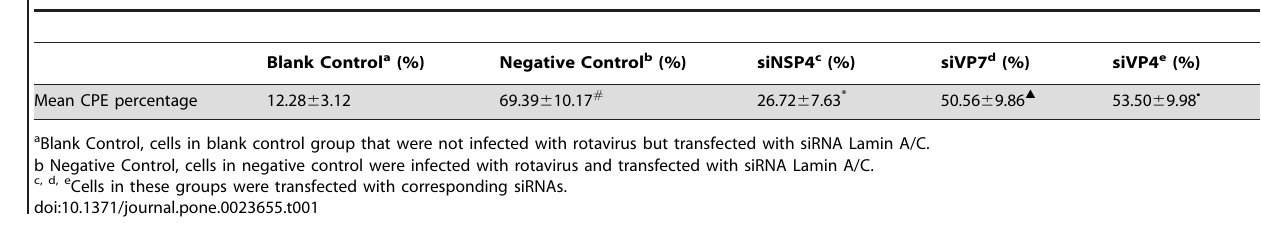
Table 1. Mean CPE percentage of different groups.